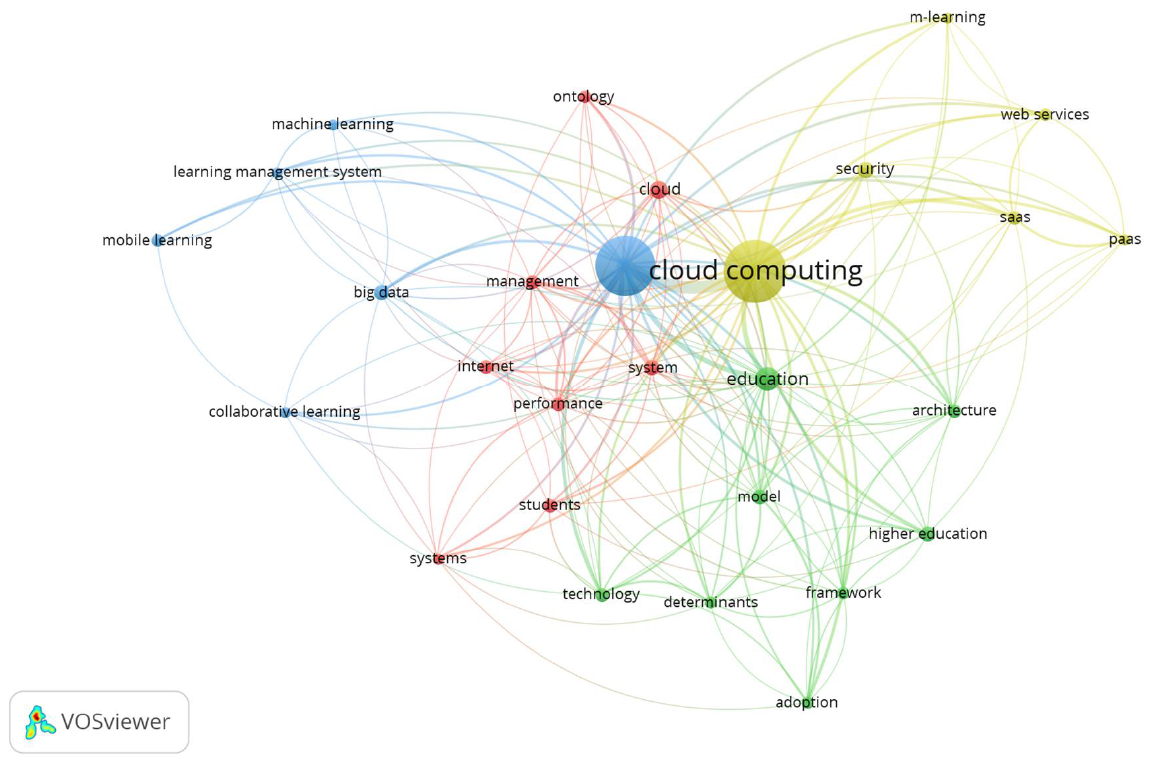
Figure 8. Conceptual structure: Co-word analysis.